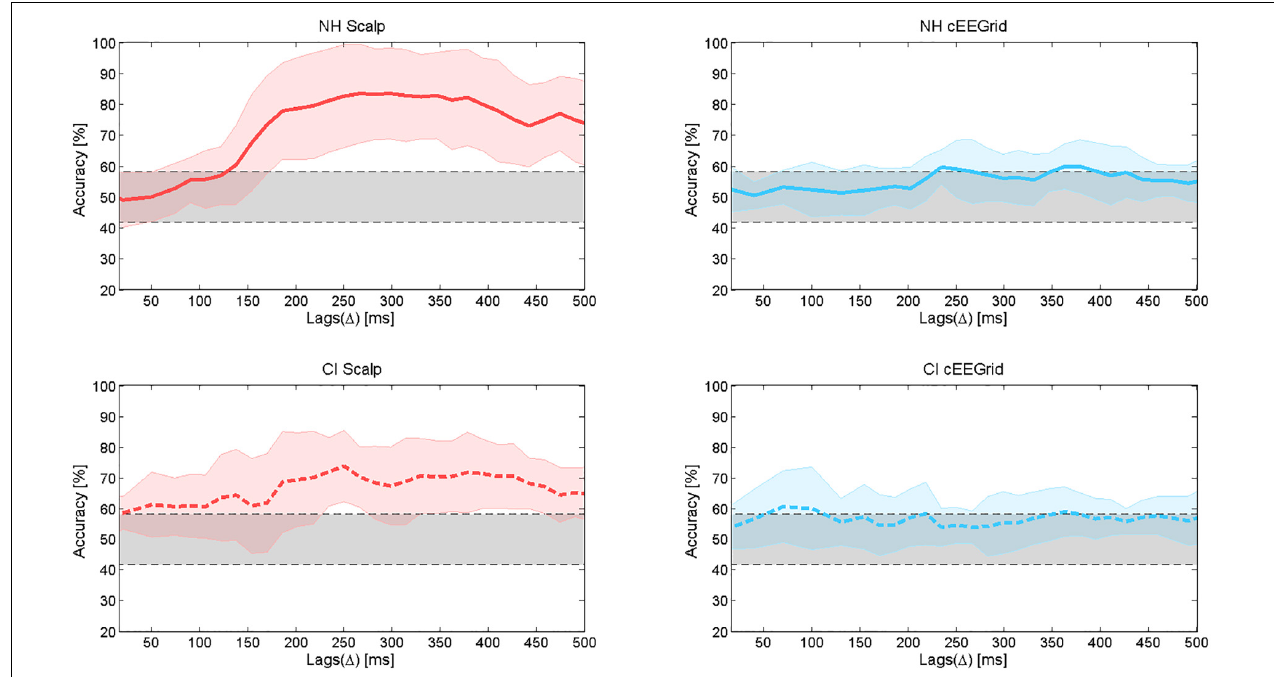
FIGURE 10 | Average decoding accuracies and standard deviation of the mean. The upper panel shows the average decoding accuracies in the group of NH listeners, for both the scalp EEG (left) and the cEEGrid (right) data. The lower panel shows the average decoding accuracies in the group of CI users, for both the scalp EEG (left) and the cEEGrid (right) data.